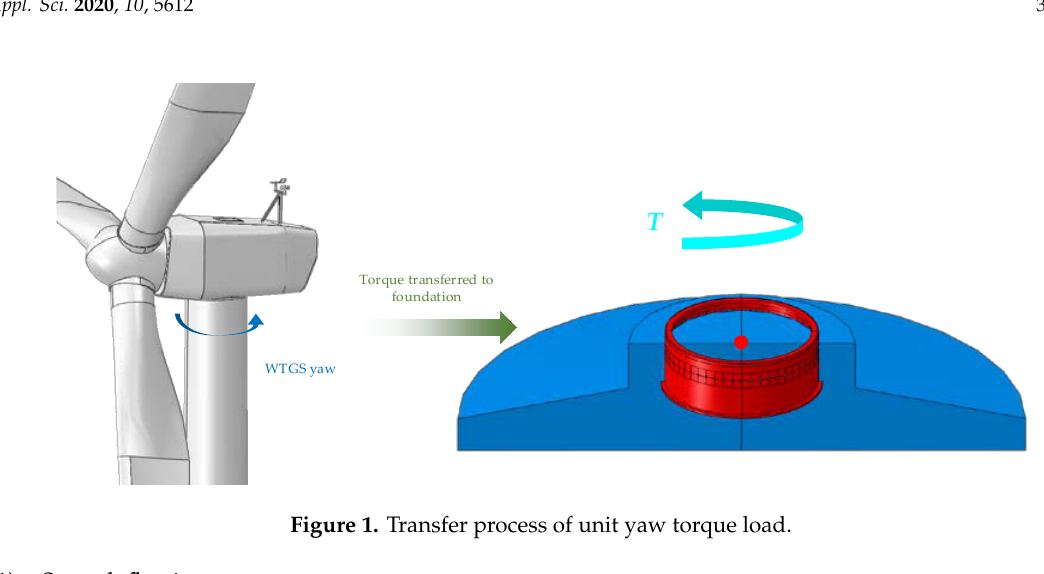
Figure 1. Transfer process of unit yaw torque load.